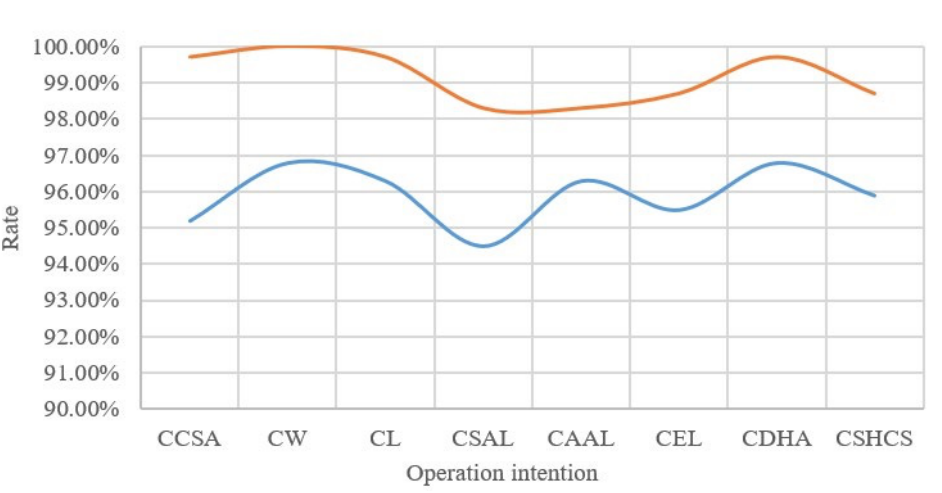
Figure 20. Correctness of intention understanding.